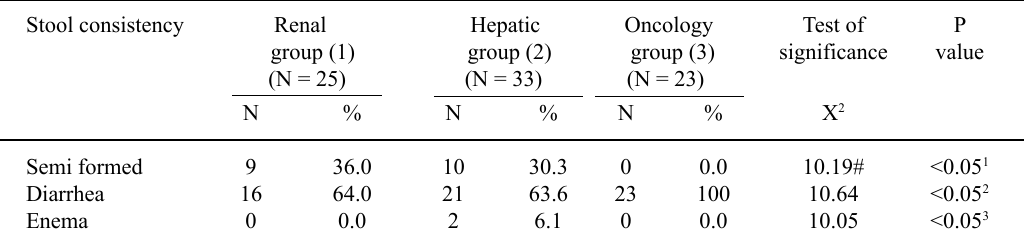
table 2. Stool consistency in different patient